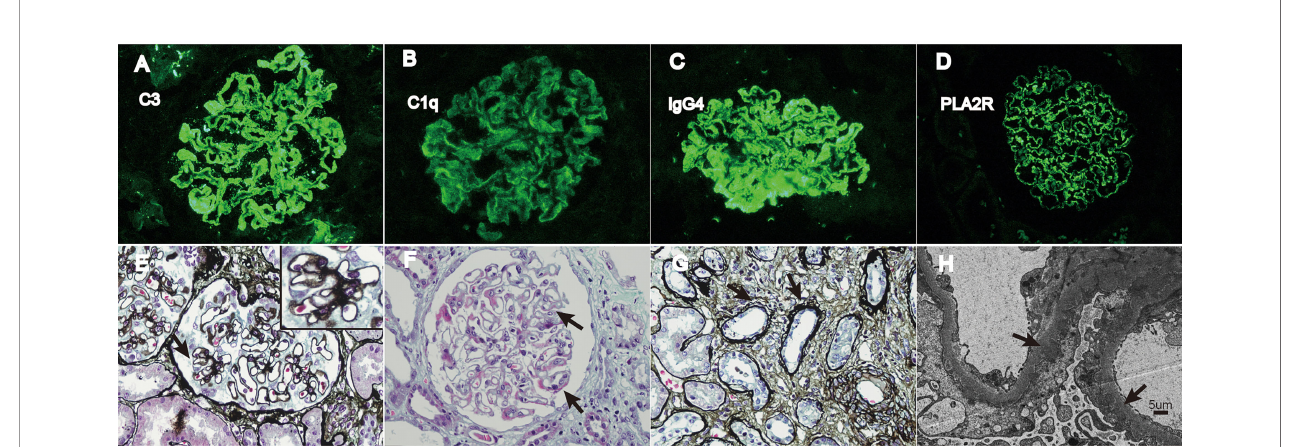
FIGURE 2 | Typical pathological images of IMN. (A – D) Immuno fl uorescence of C3, C1q, IgG4, and PLA2R deposit, respectively (×400). (E) The black arrow indicates spike-like projections in glomerulus (PASM stain, ×400). (F) The black arrow indicates immune complex deposit under epithelial cells (Masson stain, ×400). (G) The black arrow shows atrophy renal tubules (PASM stain, ×400). (H) The black arrow shows dense deposit under epithelial cells (SEM, ×3000). PASM = periodic acid-silver methenamine and Masson stain; SEM = scanning electron